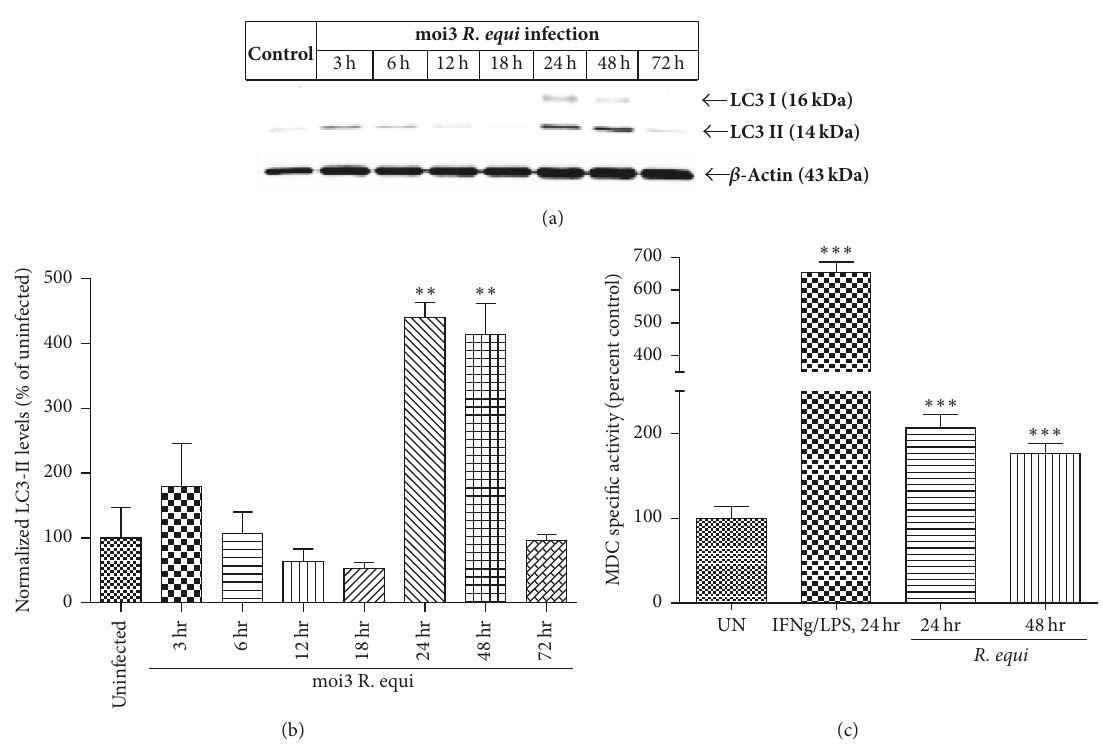
Figure 3: R. equi infection of BMDM leads to autophagy induction. (a) Western blotting analysis showing the expression of LC3-II levels in the whole cell protein lysates of BMDM infected with R. equi (moi3). LC3-II expression was observed at 24 h and 48 h. 𝛽 -Actin immunoblot represents equal protein loading. Densitometry analysis was used to quantify the density of LC3-II bands. The ratio of LC3-II bands to that of 𝛽 -actin was determined and the data are expressed as percent of control. Data represent mean ± SEM, ∗∗ 𝑝 < 0.01 compared with untreated group. (b) Following infection of BMDM with R. equi (moi3), cells were stained with MDC and the fluorescence was measured by a plate reader. A marked increase in MDC staining was evidenced in BMDM at 24 h and 48 h of R. equi infection. The results are expressed as mean ± SEM of 6 independent measurements. ∗∗ 𝑝 < 0.001 ; ∗∗∗ 𝑝 < 0.001 .